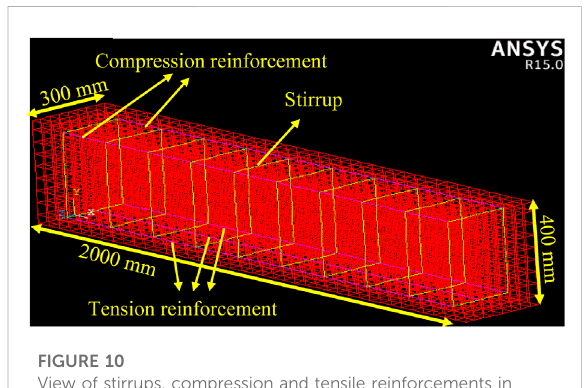
FIGURE 10 View of stirrups, compression and tensile reinforcements in the 3D model of RCB (Karalar, 2020).